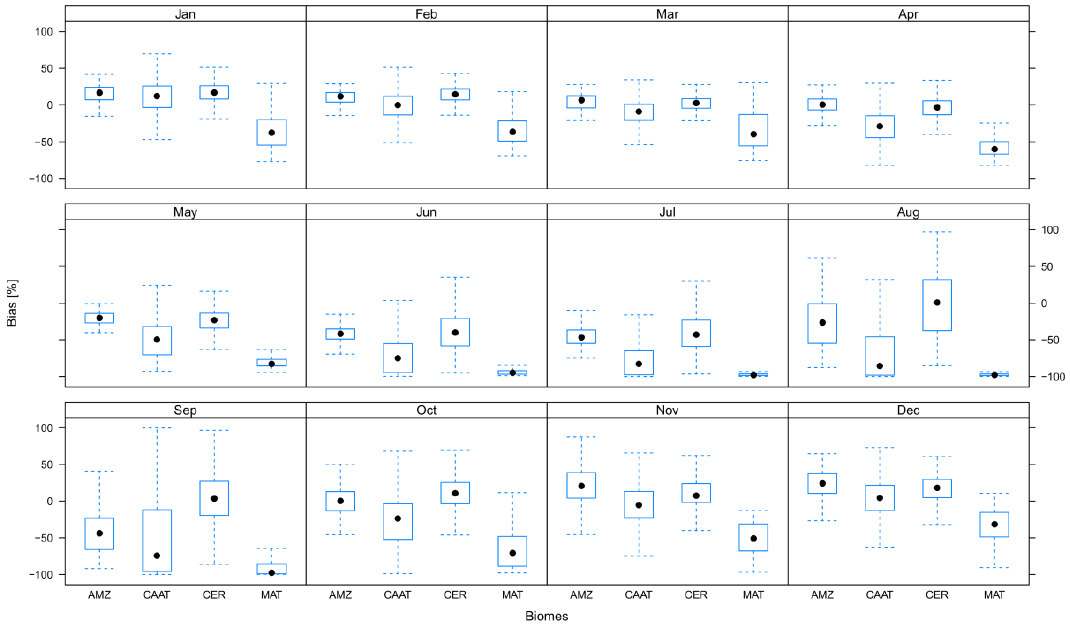
Figure 14. As per Figure 8, but for the CMORPH rainfall product during the period 2002 – 2015.